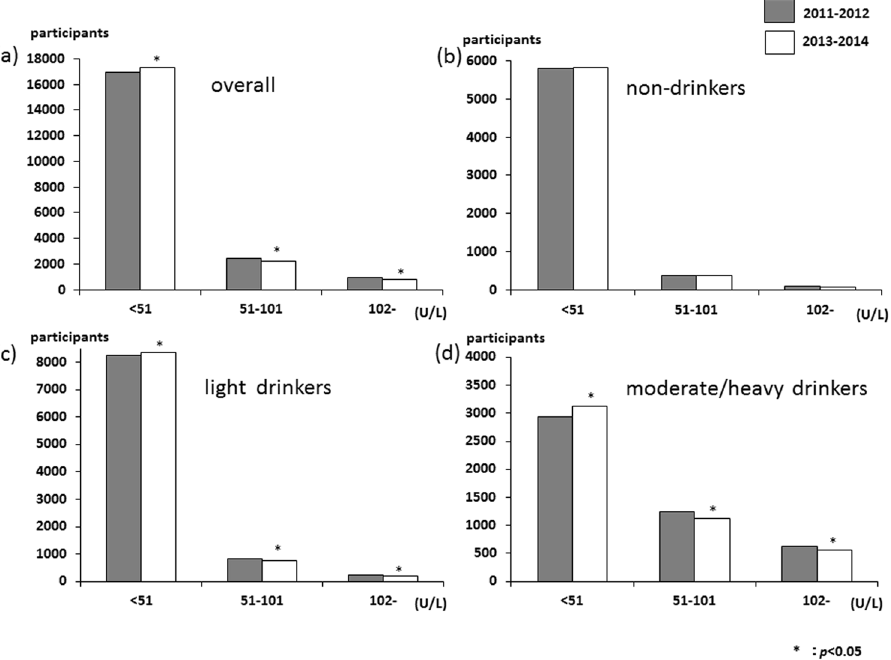
Figure 3. Distribution of serum γ -GTP ( a ) over all (n = 20395), ( b ) non-drinkers (n = 6264), ( c ) light drinkers (n = 9315), and ( d ) moderate/severe drinkers (n = 4816).